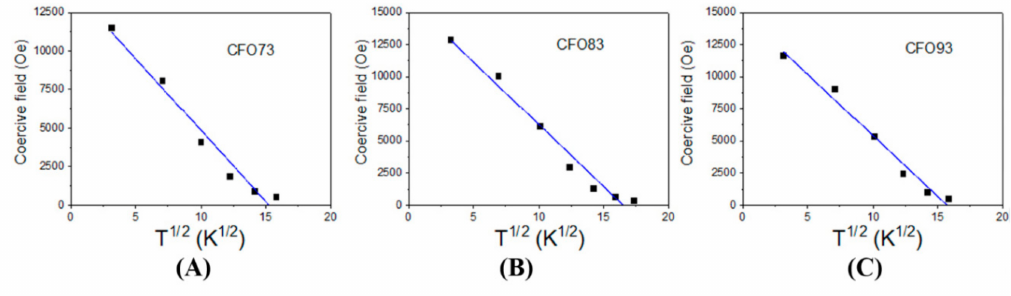
Figure 5. Dependence of coercive magnetic field on T 1 / 2 for CFO73 ( A ), CFO83 ( B ), and CFO93 ( C